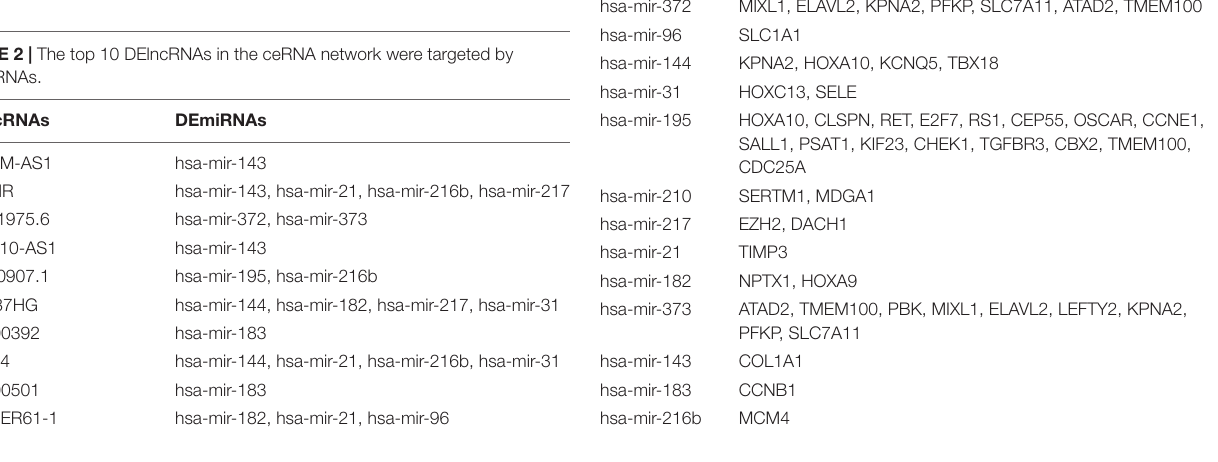
(82 upregulated and 35 downregulated, Figures 2A,B ), and 2729 mRNAs (2055 upregulated and 674 downregulated, Figures 3A,B ) were identified as differentially expressed RNAs in LUAD. The top 10 DElncRNAs, DEmiRNAs, and DEmRNAs with their names, log2FC values, and P -values are listed in Supplementary Table 1 .